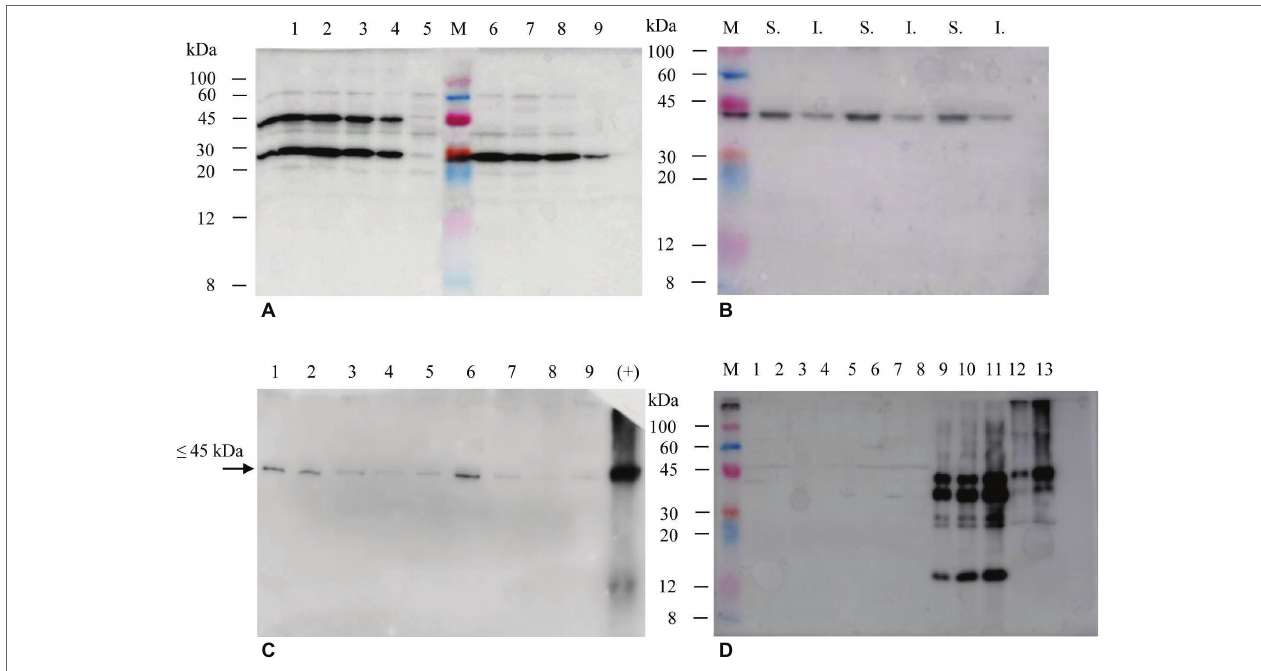
FIGURE 4 | Immunoblotting of extracts (15 μg TSP) from Micro-Tom hairy root clones obtained after transformation with His 6 -E7*-SAPKQ, His 6 -SAPKQ or His 6 -E7* constructs. (A) Accumulation of recombinant His 6 -E7*-SAPKQ and His 6 -SAPKQ in extracts from different clonal hairy root lines (anti-SAP polyclonal antibody). Lanes 1–4, four His 6 -E7*-SAPKQ best expressing clones; lane 5, hairy root clone expressing an irrelevant gene; M, Marker Color burst™, Sigma; lanes 6–8, three His 6 - SAPKQ best expressing clones; lane 9, reference standard (His 6 -SAPKQ from E. coli ; 25 μg); hairy root clone expressing an irrelevant gene. (B) Immunoblotting on soluble (S.) and insoluble (I.) fractions from extract (5 μg TSP) of three representative His 6 -E7*-SAPKQ-expressing clones (anti-E7 polyclonal antibody). (C) 5 μg TSP from the two best clones expressing His 6 -E7*-SAPKQ were assayed at different time points after subculture (day 7, 14, 28, 35, and 42; anti-E7 polyclonal antibody was used). Day 7, lane 1 (clone 1); day 14, lane 2 (clone 1), lane 6 (clone 2); day 28, lane 3 (clone 1), lane 7 (clone 2); day 35, lane 4 (clone 1), lane 8 (clone 2); day 42, lane 5 (clone 1), lane 9 (clone 2); lane 10, reference standard (His 6 -E7*-SAPKQ purified from E. coli , 100 ng; anti-E7 polyclonal antibody was used). (D) Assay of extracts from hairy root clones obtained after transformation with pEAQ-HT/His 6 -E7*. M, Marker Color burst™; lanes 1–8, kanamycin-resistant clones obtained after transformation and not expressing His 6 -E7*; lanes 9–11, reference standard (50, 75, 100 μg TSP from concentrated extracts of N. benthamiana expressing His 6 -E7*-SAPKQ); lanes 12-13, 1.5 and 5 μg TSP of one representative hairy root clone expressing His 6 -E7*-SAPKQ (anti-E7 polyclonal